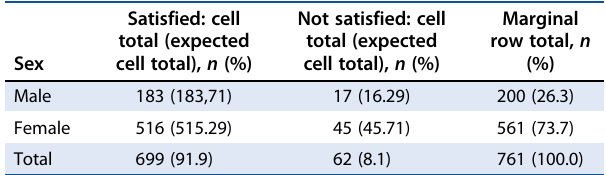
Table 3: Comparison of patient satisfaction by sex